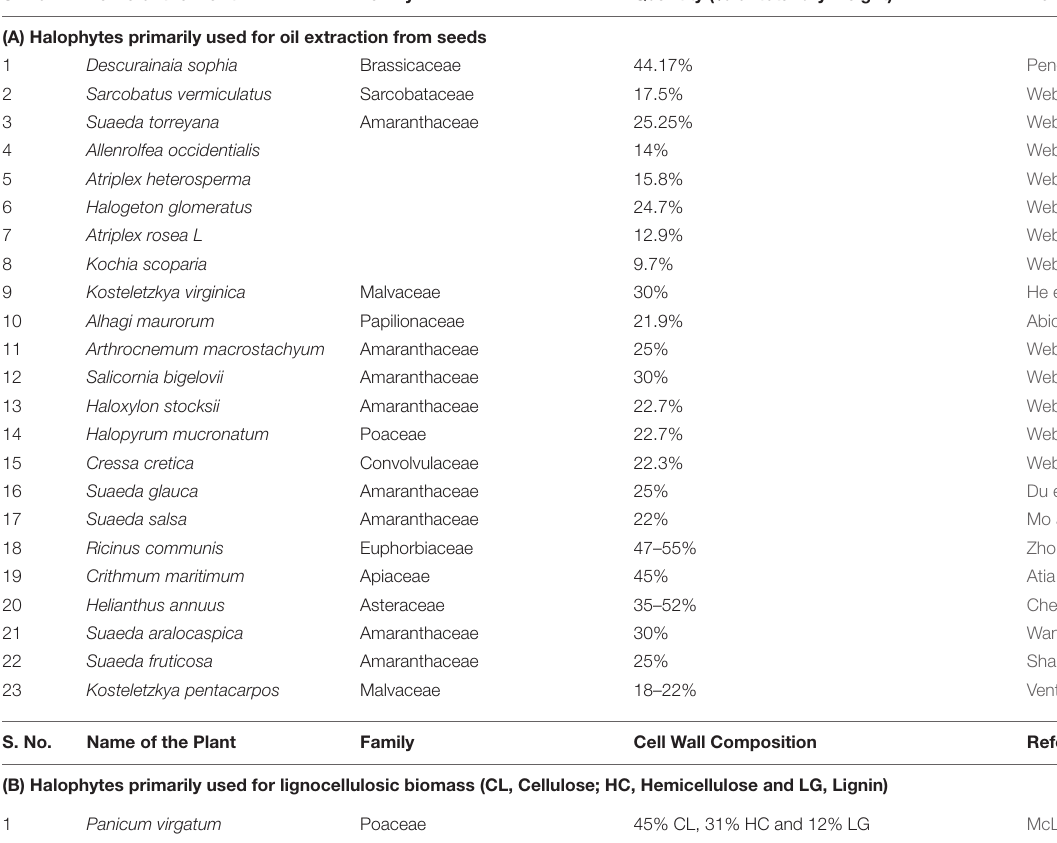
TABLE 1 | List of Halophyte species assessed for oil and lignocellulosic biomass yields. S.